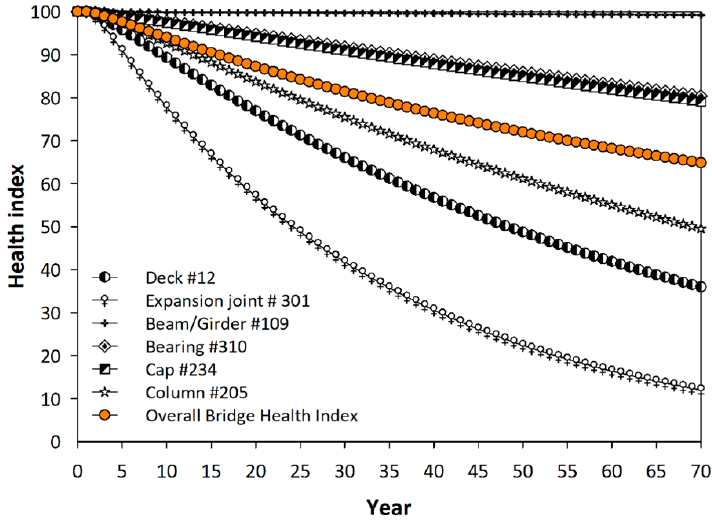
Figure 11. Bridge overall and element health index prediction models (group PC109).